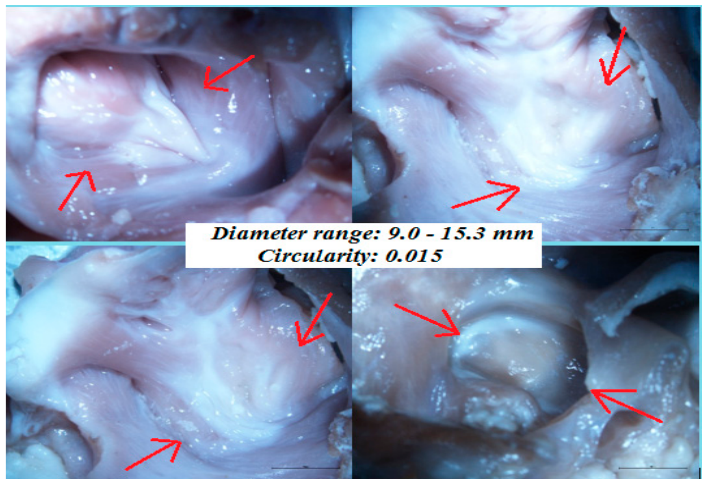
Figure 9. Red arrows indicate the location of fossa ovalis .